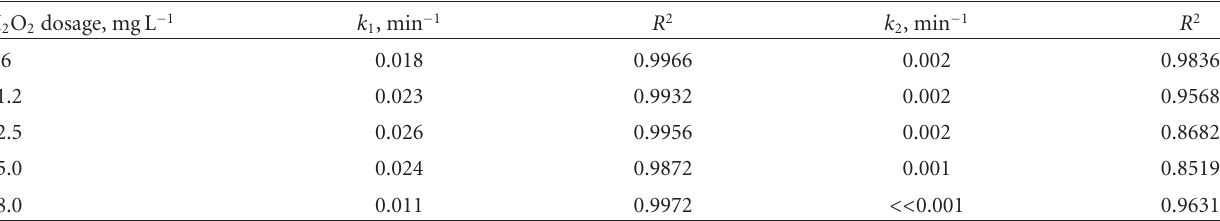
Table 2: Determination of the two-step consecutive kinetic constant for the photocatalytic degradation of MCB at di ff erent H 2 O 2 dosage. H 2 O 2 dosage, mgL −